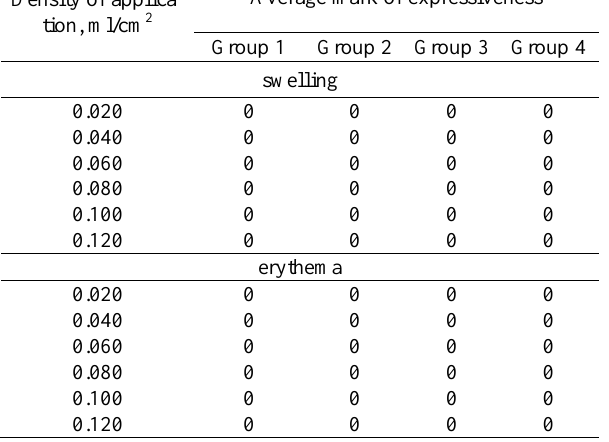
Characteristics of the local irritant action of the drug “Ferosel T”, with a single effect on the skin of the rabbits (M ± m; n = 3) Density of applica- tion, ml/cm 2